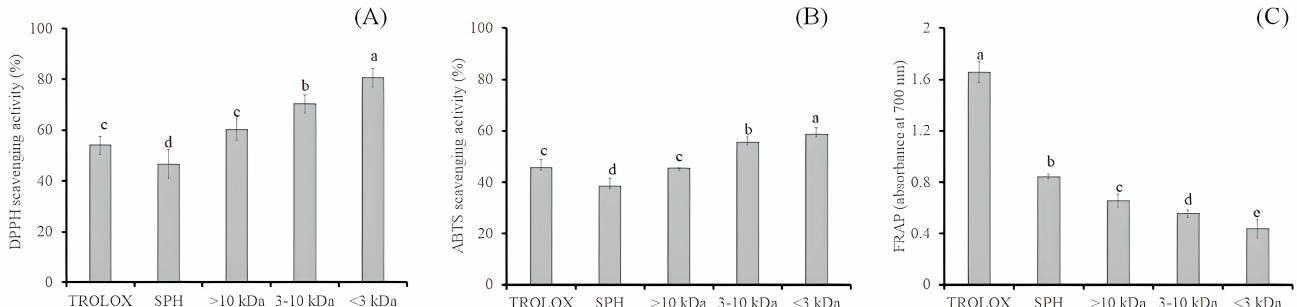
Figure 3. Antioxidant activities of Oligopeptide fractions. DPPH scavenging activity ( A ), ABTS scav- enging activity ( B ), and Ferric (Fe 3+ ) reducing power ( C ). Data expressed as mean ± SD, ( n = 3). Bars with different alphabets are significantly different at p < 0.05.